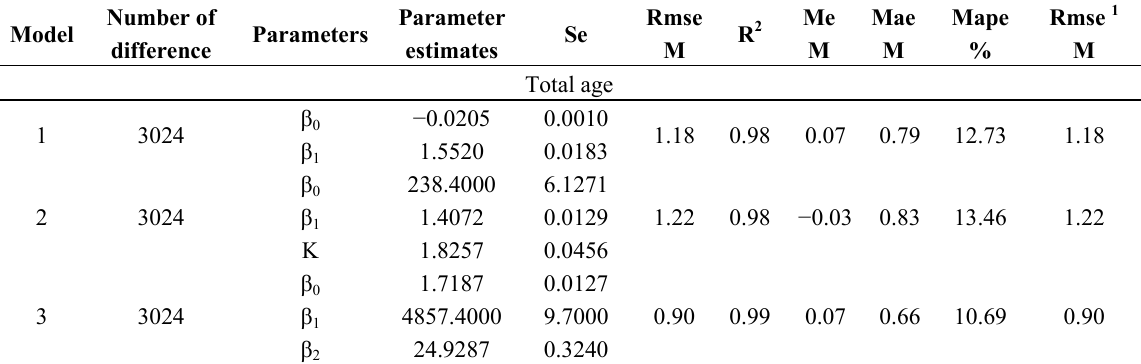
Table 2. Estimated parameters and standard errors for models (1–3).